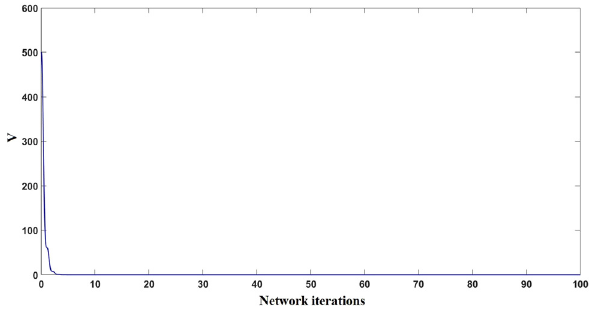
Figure 7: Network ’ s Lyapunov